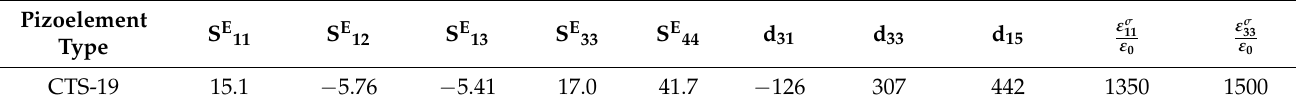
Table 4. Elastic compliance of S E pq ( × 10 − 12 PA), piezoelectric d fp moduli (pC/N) and